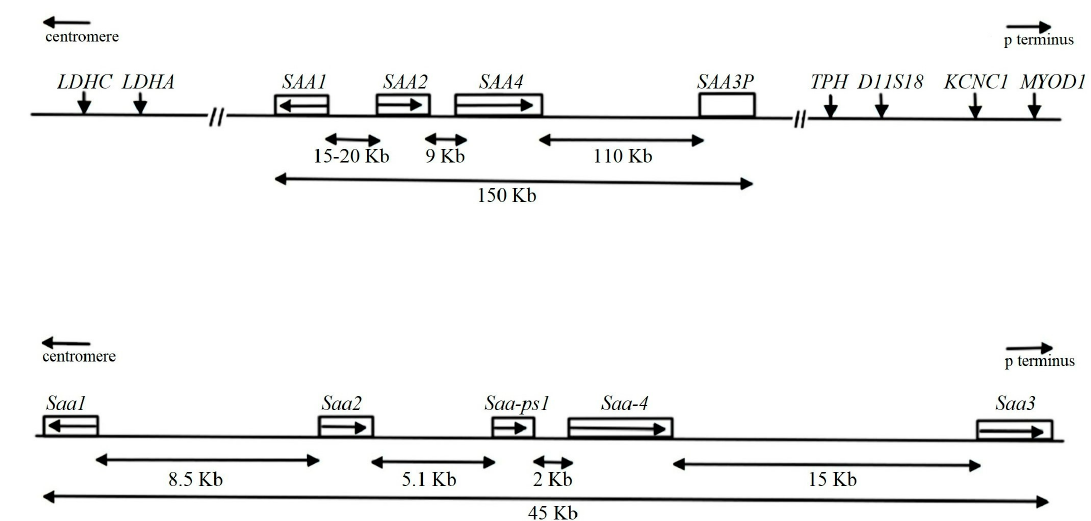
Figure 1. Map of the human and mouse SAA gene families. The human family spans 150 kb on chromosome 11p15.1, and the mouse family spans 45 kb on chromosome7p. The relative positions of flanking genes are indicated in the human cluster. Arrows within SAA genes indicate 5 ′ → 3 ′ orientation of the gene. The human genes (top), SAA1 and SAA2 encode two major acute-phase proteins, and SAA3 (SAA3P) is a pseudogene. SAA4 encodes a constitutively expressed protein. MouseSaa1 (designated Saa1.1), Saa2 (designated Saa2.1), and Saa3 encode three acute-phase SAA isoforms. Mouse Saa4 encodes a constitutively expressed SAA isoform and is present at lower levels (bottom).